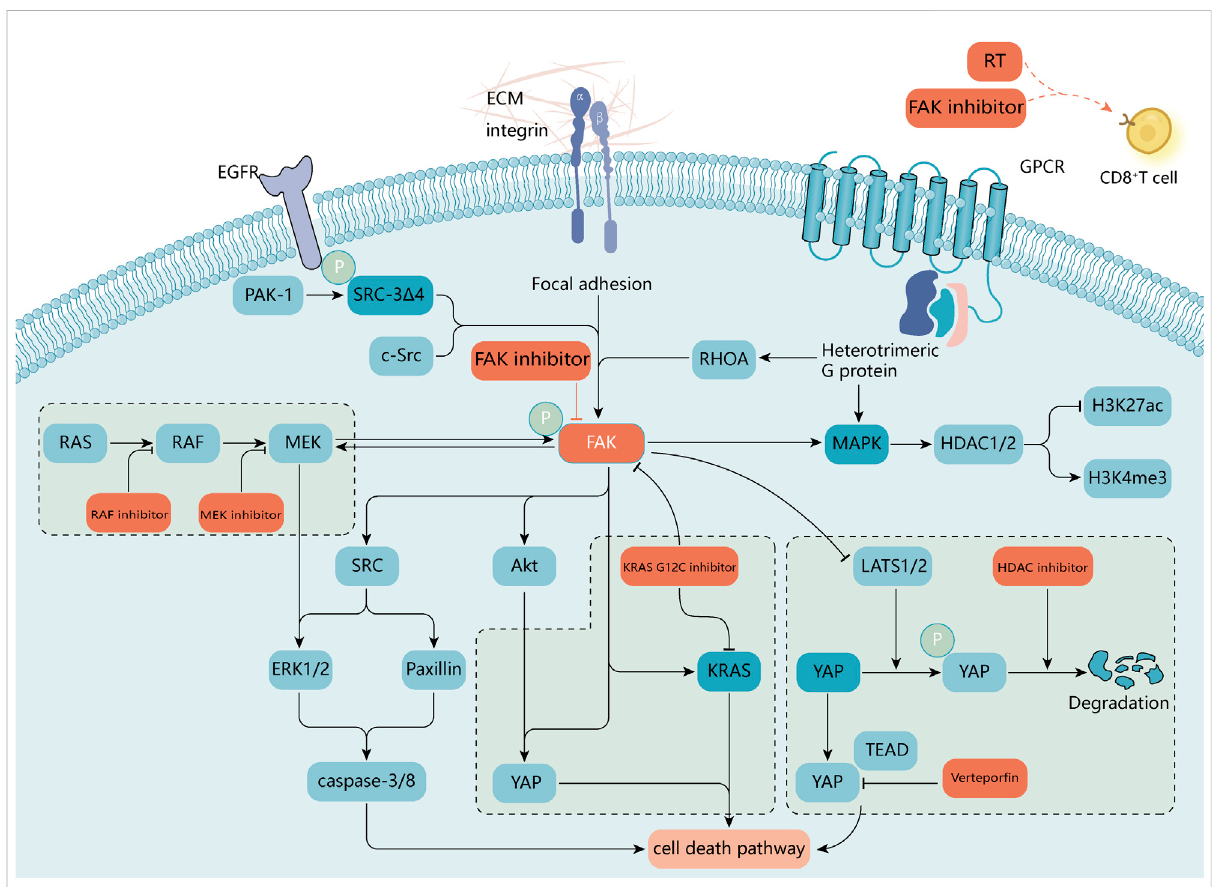
FIGURE 6 A molecular target for combination therapy with FAK inhibitors. FAK supports a variety of oncogenic processes and is bene fi cial in combination with a variety of available antitumor agents. In RAS-mutated or RAF-mutated cancer cells, blocking the RAS-RAF-MEK pathway with RAF or MEK inhibitors activates FAK and promotes cell survival by reactivating ERK signaling. Activated FAK in diffuse gastric cancer and uveal melanoma attenuates the negative regulation of the transcriptional activator YAP by large tumor suppressor 1 and 2 (LATS1/2). FAK activity can promote nuclear translocation of YAP, and combinations of FAK inhibitors with inhibitors of YAP expression [e.g., histone deacetylase (HDAC) inhibitors] or transcriptional activity may be required to enhance inhibition of oncogenic YAP signaling (Hicks-Berthet and Varelas, 2017; Song et al., 2021). Inhibition of RHOA or FAK selectively induces mutant KRAS cell death in non-small cell lung cancer studies (Konstantinidou et al., 2013). In breast cancer sRc-3 Δ 4, a splice isoform of the oncogene was found to be a signaling adapter linking EGFR and FAK and promoting EGF-induced phosphorylation of FAK and c-Src (Long et al., 2010). FAK inhibitors also play a role in epigenetics (Romito et al., 2022), and radiation treatment in combinationwithFAKinhibitorsaffectstheimmunemicroenvironmentsurroundingthetumor(Osipovetal.,2021).ThesmallGTPase,RAShomolog family member A (RHOA), regulates the actin cytoskeleton. ECM, extracellular matrix; GPCR, G protein-coupled